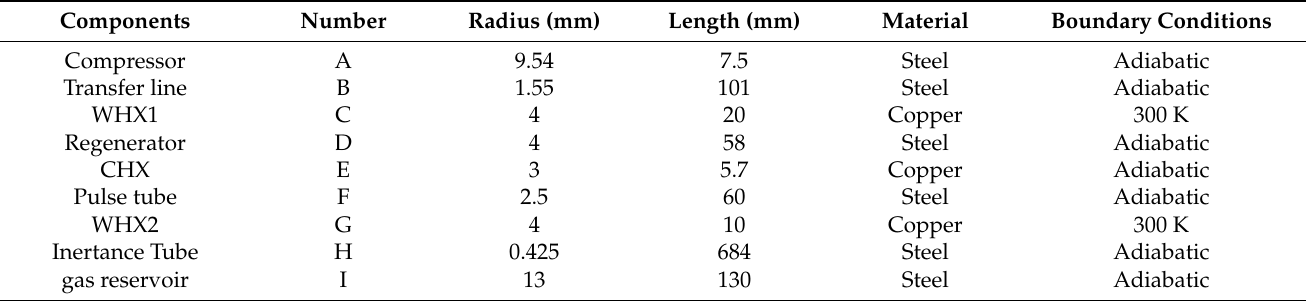
Table 1. Geometry dimensions and boundary